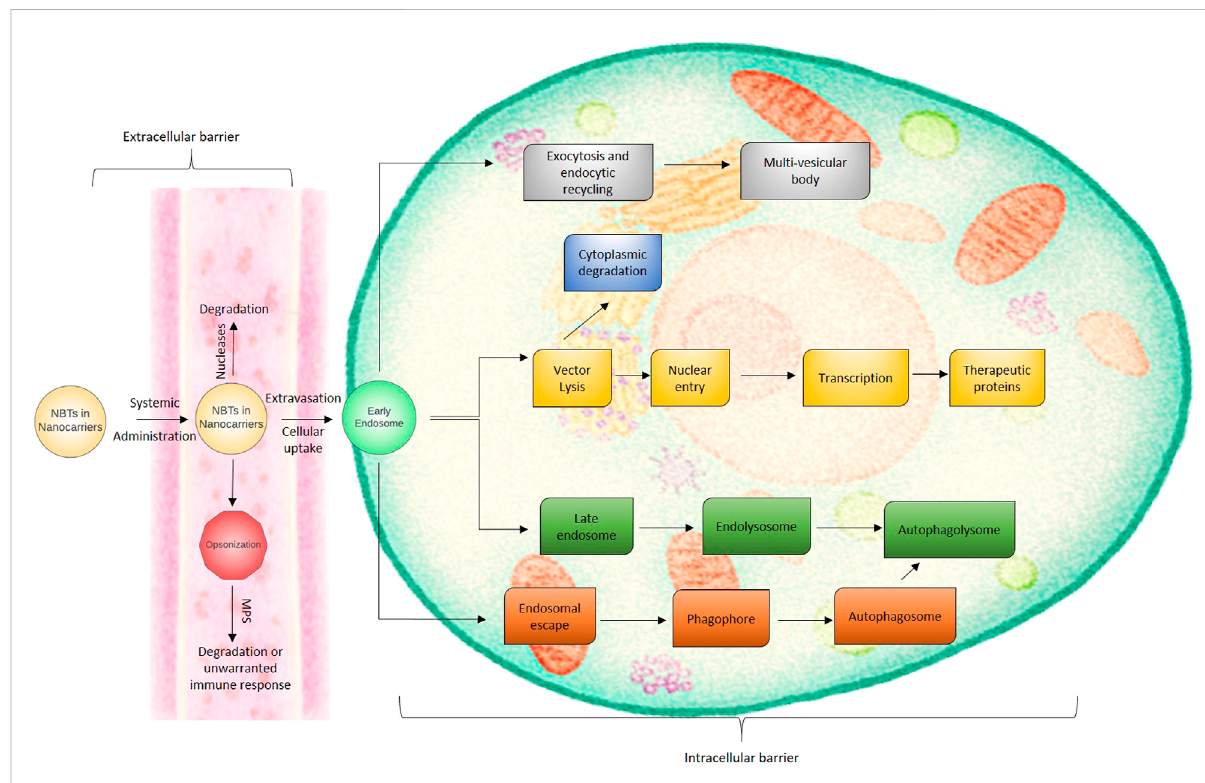
FIGURE 2 The extracellular and intracellular biological barriers for nanocarrier based NBT